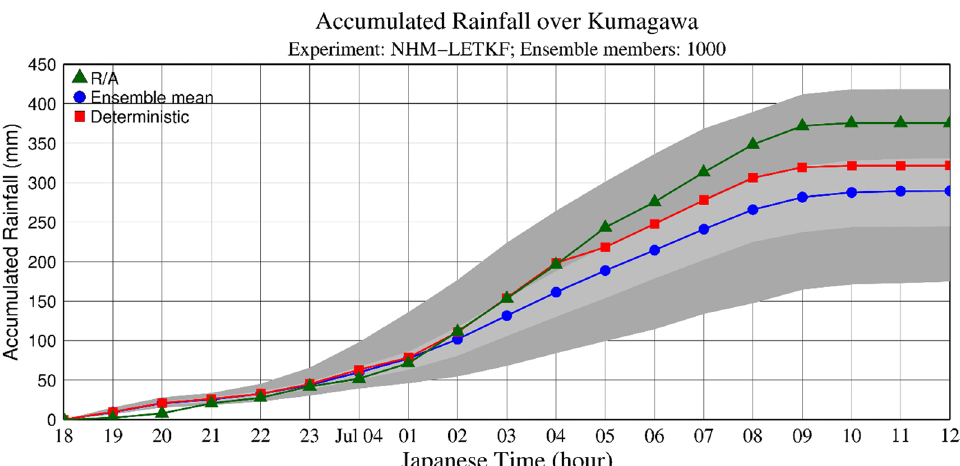
Fig. 3 Evolutions of the accumulated precipitation averaged over the Kumagawa catchment as forecasted by NHM-LETKF. The light gray zone represents the intervals between the first and third quartiles of the probability density functions of the accumulated rainfall. The dark gray zone indicates the 95% confidence intervals, i.e., the intervals between the 2.5 and 97.5 percentiles, of the probability density functions of the accumulated rainfall (Reproduced Duc et al.